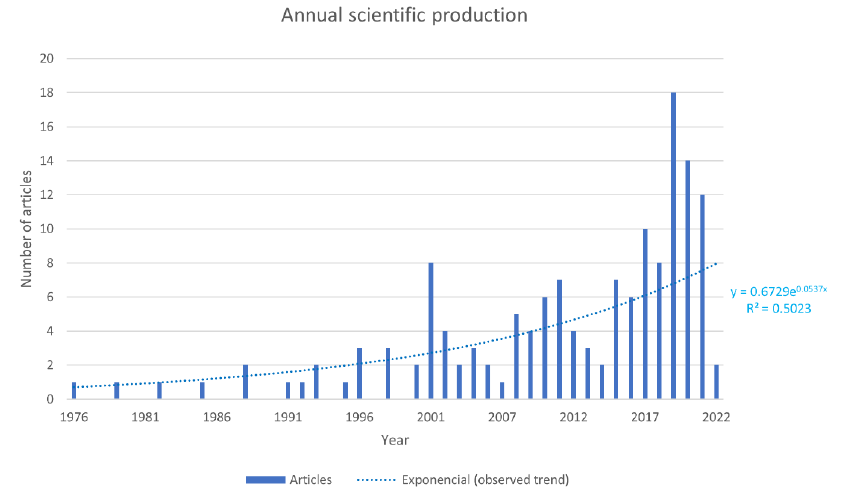
Figure 2. Annual production of articles during the period 1976 – 2022.